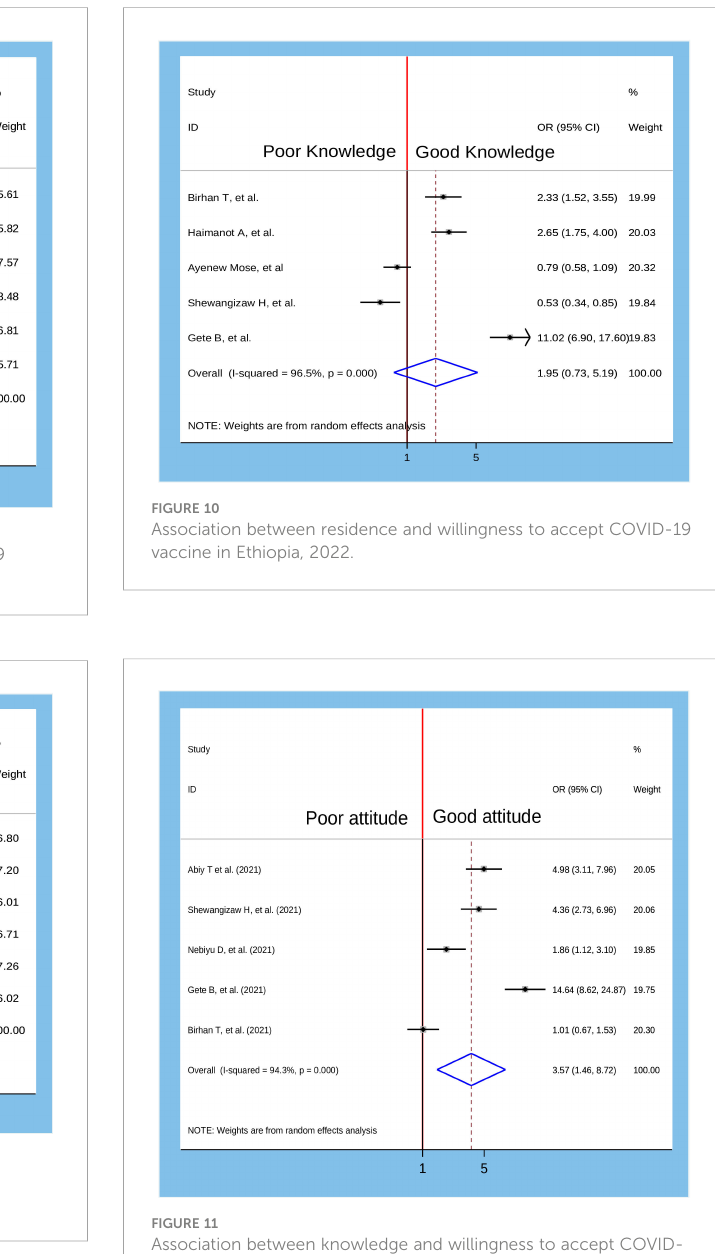
FIGURE 11 Association between knowledge and willingness to accept COVID- 19 vaccine in Ethiopia,